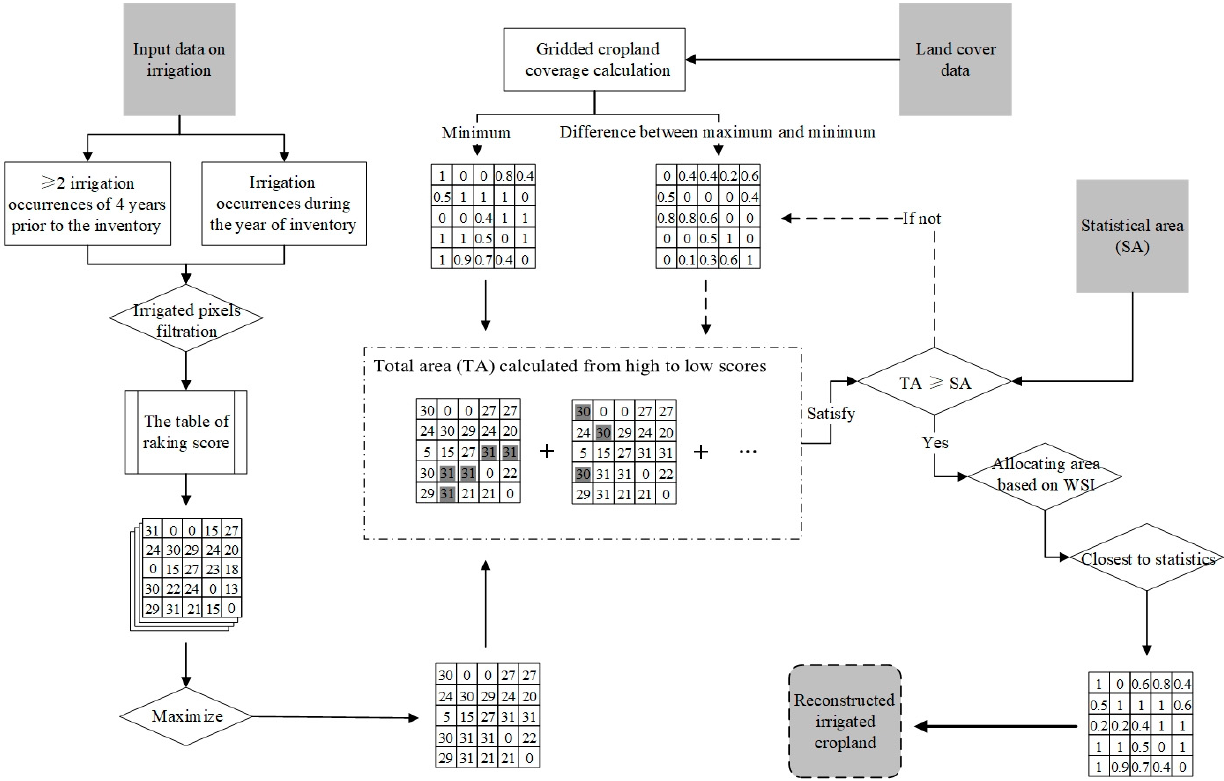
Figure 2. The scheme used for developing annual irrigation maps for mainland